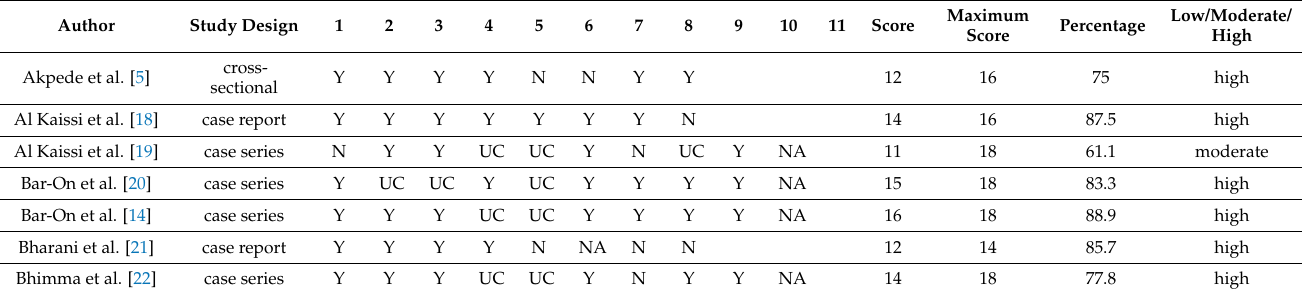
Table A2. Overview Table of Methodological Appraisal and